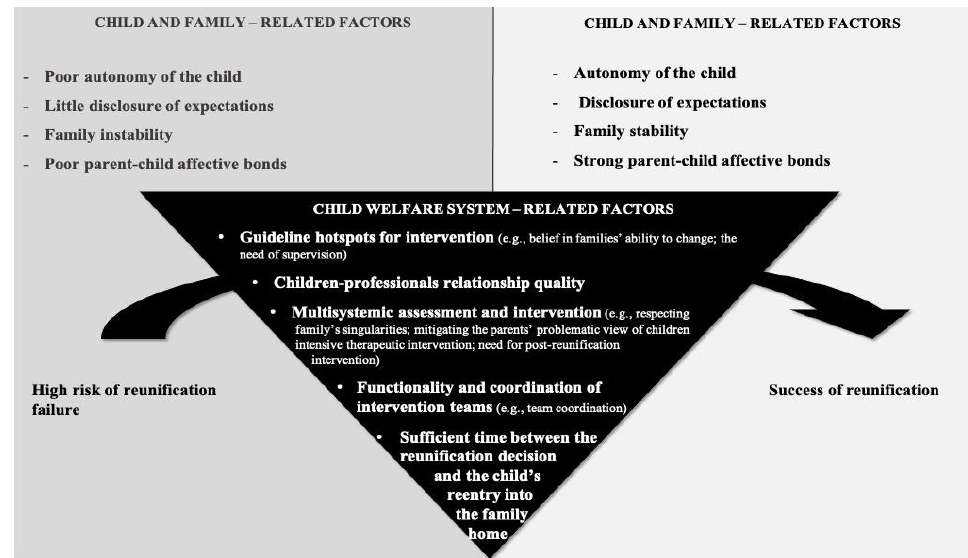
Figure 2. Dynamic Interactions Among Factors for Family Reunification Success.